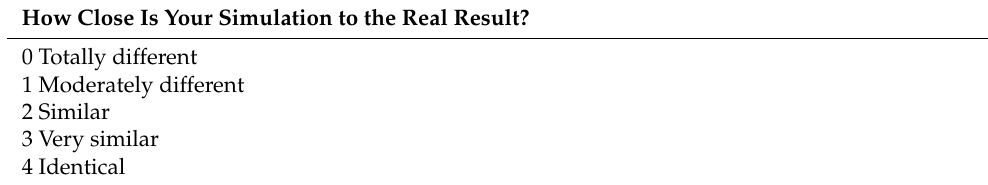
Table 1. Breast augmentation simulation assessment scale developed by the first author (SLP). How Close Is Your Simulation to the Real